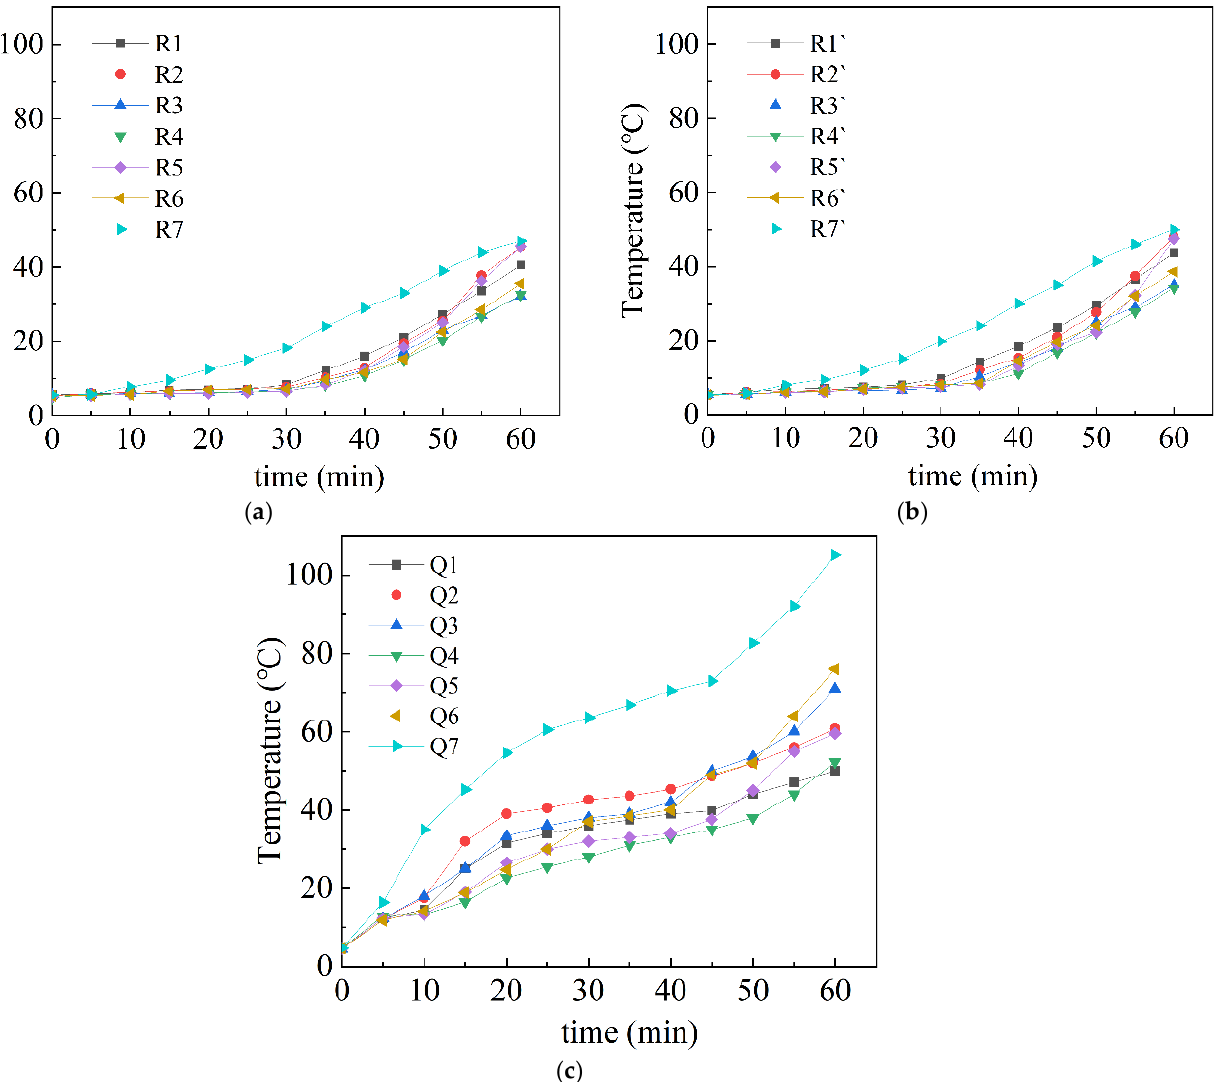
Figure 12. T-t curve at the measurements points of test M: ( a ) panel A1; ( b ) panel A2; ( c ) panel B.